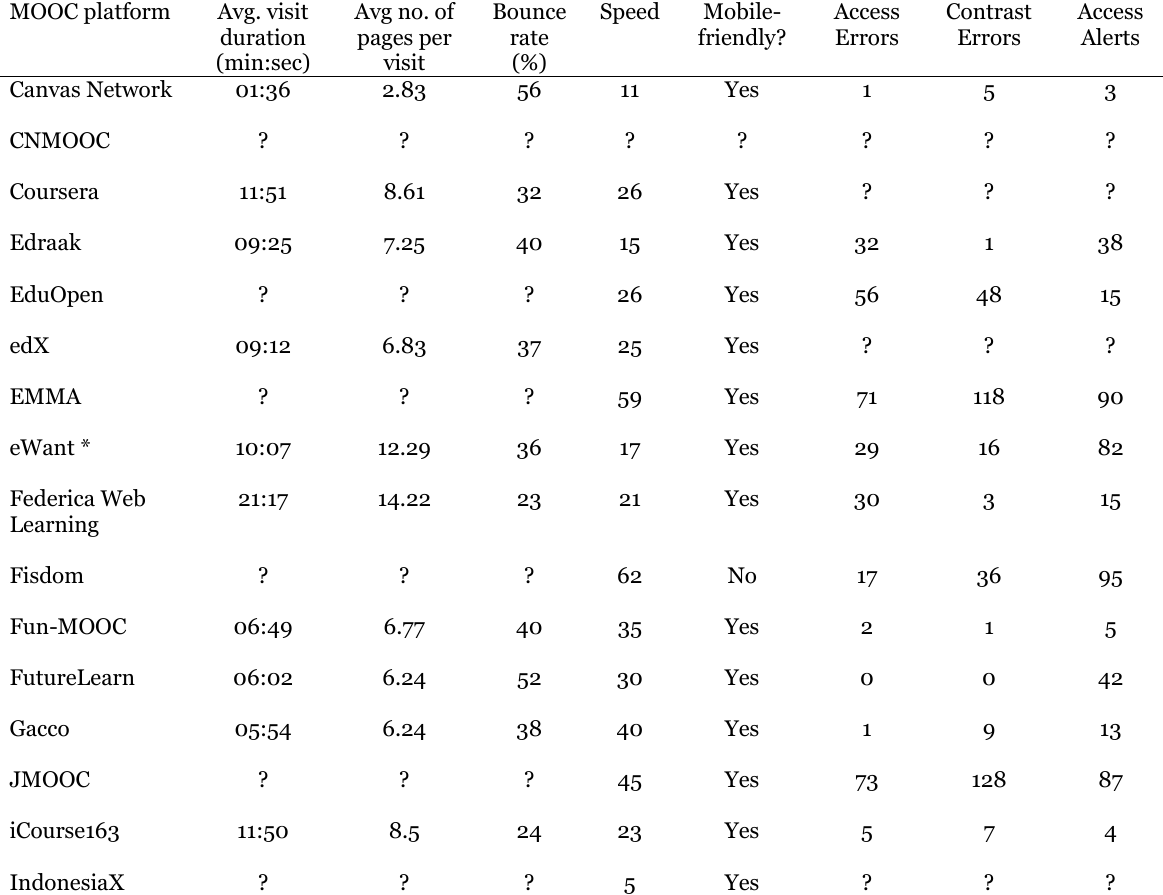
MOOC Platforms: Visitor Engagement and Technical Characteristics MOOC